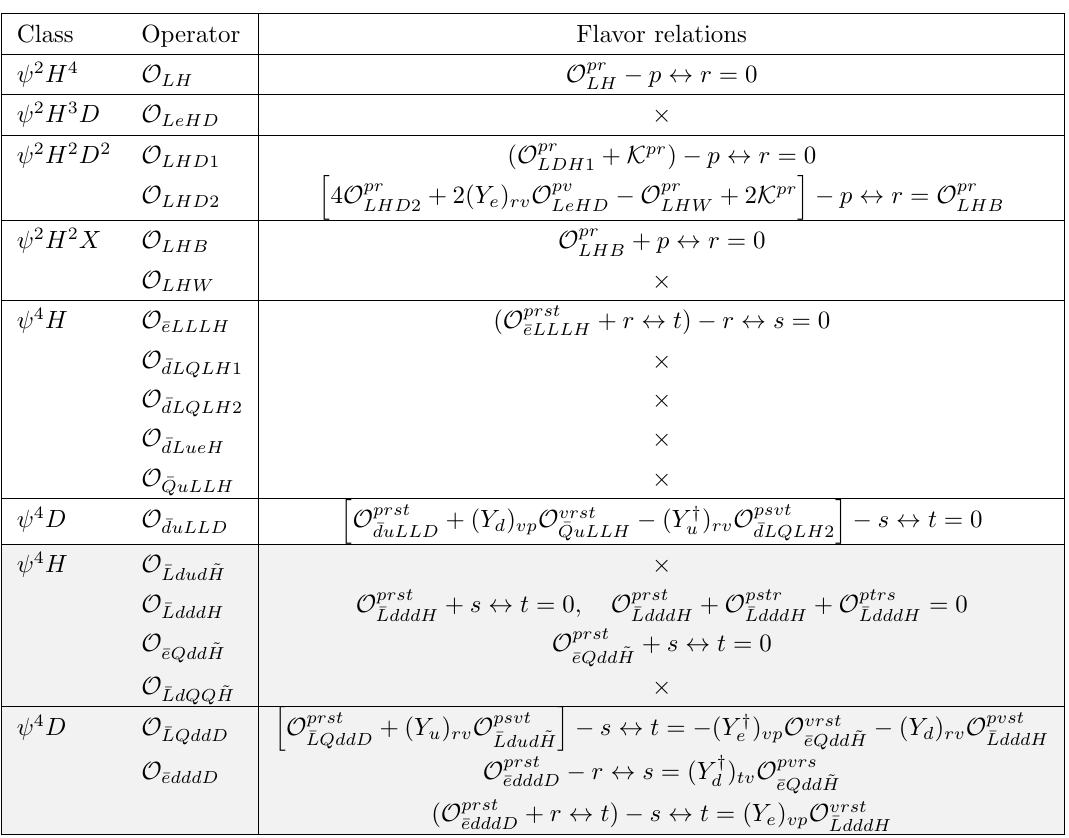
Table 2 . Flavor relations for dim-7 operators. The symbol (cid:2) indicates lack of such a relation.